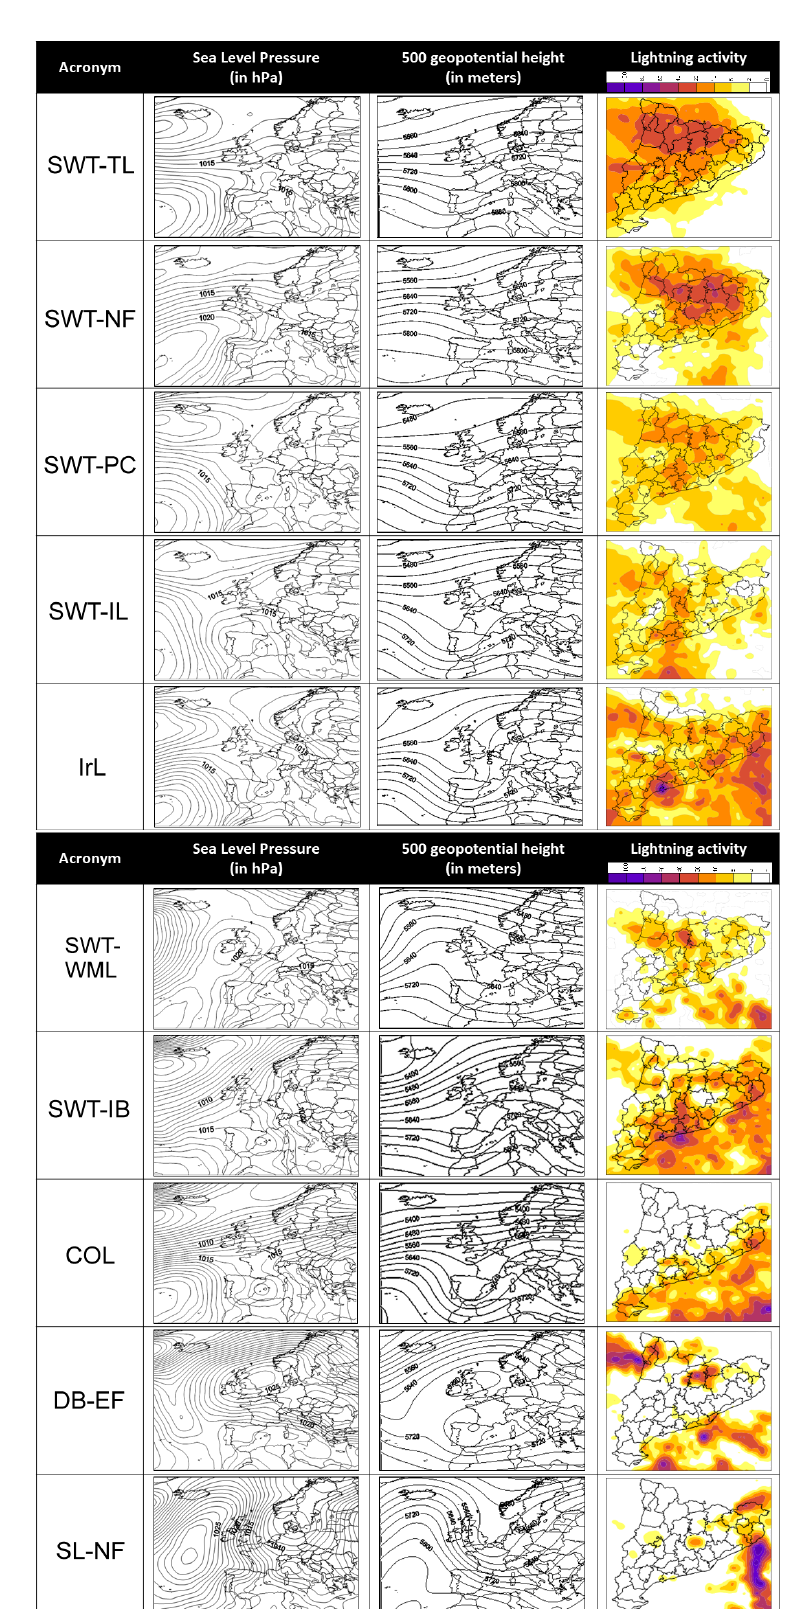
Figure 2. Synoptic weather patterns (10) linked to lightning activity in Catalonia. Each SWP is characterised by the average sea level pressure (left column), the geopotential at 500hPa (middle column) and the averaged lightning distribution (right